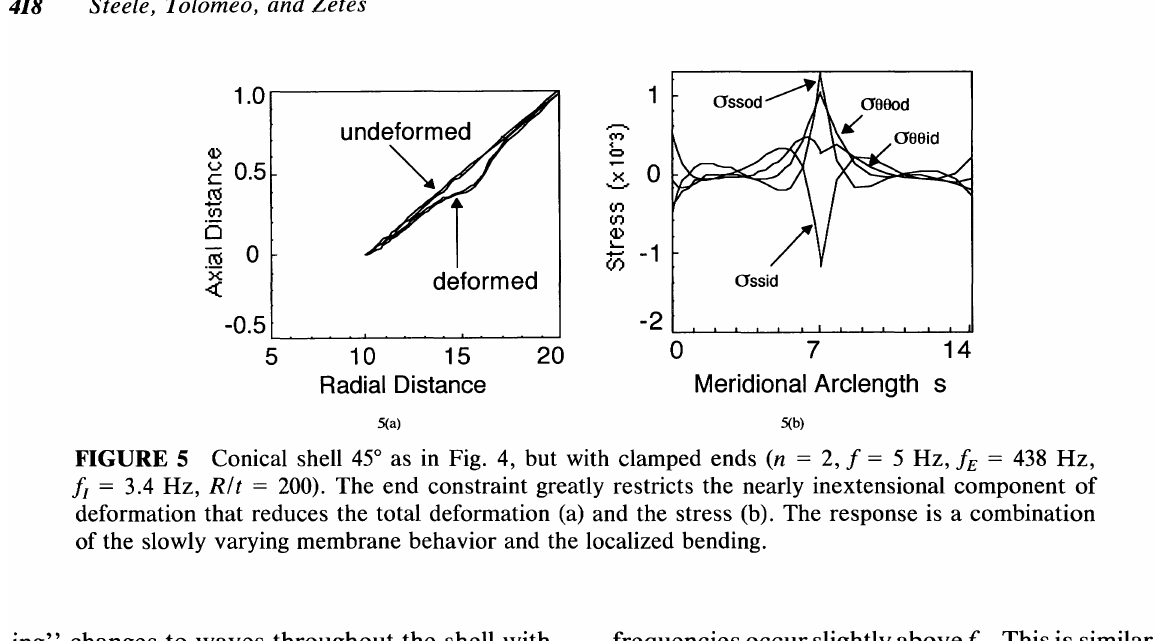
FIGURE 5 Conical shell 45° as in Fig. 4, but with clamped ends (n = 2, f = 5 Hz, fE = 438 Hz, h = 3.4 Hz, Rtt = 200). The end constraint greatly restricts the nearly inextensional component of deformation that reduces the total deformation (a) and the stress (b). The response is a combination of the slowly varying membrane behavior and the localized bending.